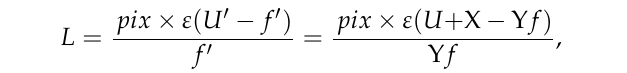
( b ) Figure 5. The geometric relationship between the combination of the camera and laser rangefinder and the target plane in clockwise direction: ( a ) horizontal length transformation; ( b ) vertical propor- tional relationship.